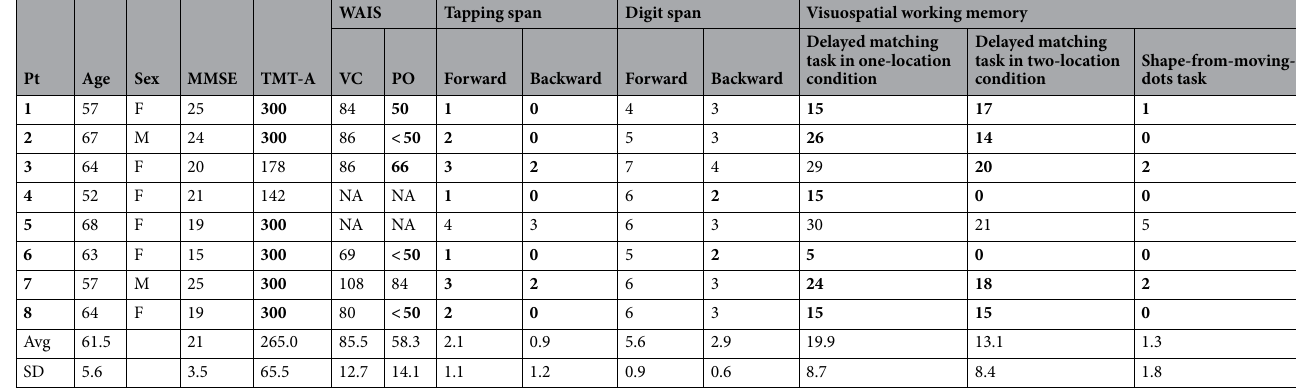
Table 2. Individual results of neuropsychological assessment for patients with posterior cortical atrophy. Maximum time on the TMT-A was 300 s; participants not finishing with that time limit are indicated by 300. MMSE Mini-Mental State Examination, NA not applicable, TMT-A Trail Making Test-A, WAIS Wechsler Adult Intelligence Scale, VC Verbal Comprehension, PO Perceptual Organization. Values in bold font represent those of below 5%